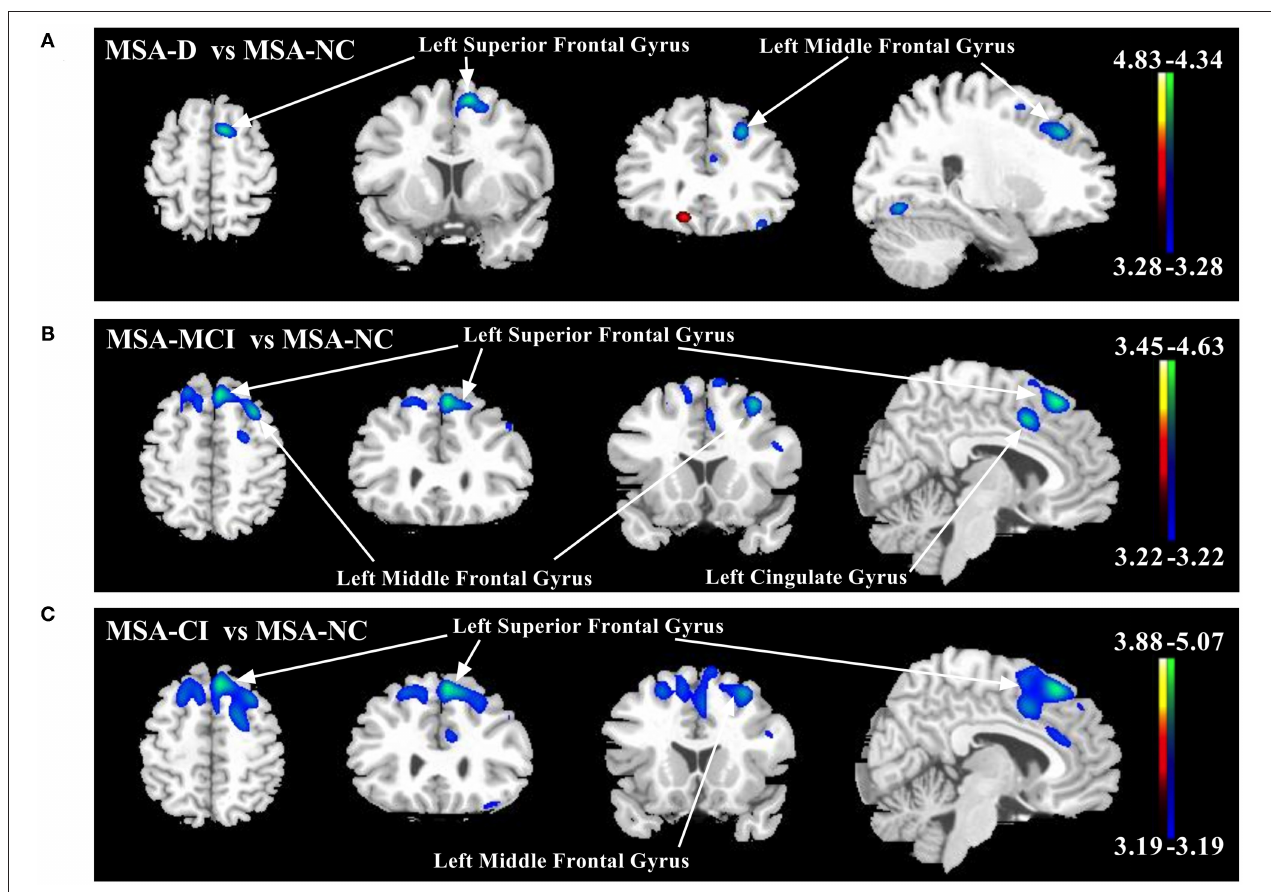
FIGURE 1 | Comparison of regional cerebral metabolic changes across three cognitive statuses (MSA-D, MSA-MCI, and MSA-NC) utilizing voxel-based SPM analysis. (A) MSA-D patients displayed hypometabolism (blue–green) in left middle frontal gyrus and superior frontal gyrus compared with MSA-NC. (B) MSA-MCI patients displayed hypometabolism in left middle frontal gyrus, bilateral superior frontal gyrus, and cingulate gyrus. (C) MSA-CI patients displayed hypometabolism in left middle frontal gyrus and superior frontal gyrus compared with MSA-NC. All changes of metabolism are overlaid on a structural MRI brain template. White arrows indicate the representative brain regions. The thresholds of the color bars depict T- values and voxel threshold was set at p <